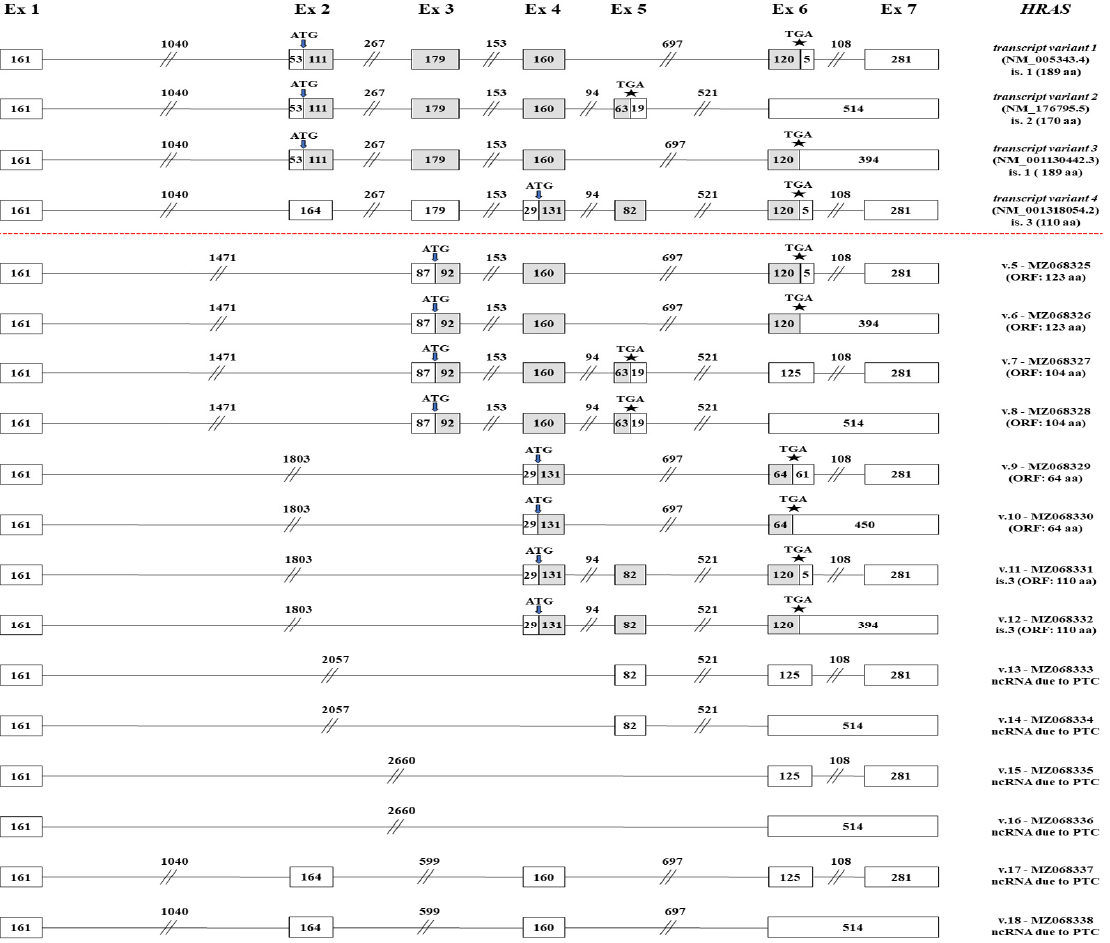
Figure 4. Detailed structural demonstration of the 14 novel HRAS transcript variants ( HRAS v.5 – v.18) identified in the current study. Exons are exhibited as boxes and introns as lines, while the numbers that characterize every box and line correspond to their length in nucleotides. Gray and white boxes represent coding and non-coding regions, respectively. The positions of the ATG and stop codons are pointed out with arrows ( ↓ ) and asterisks (*), accordingly.